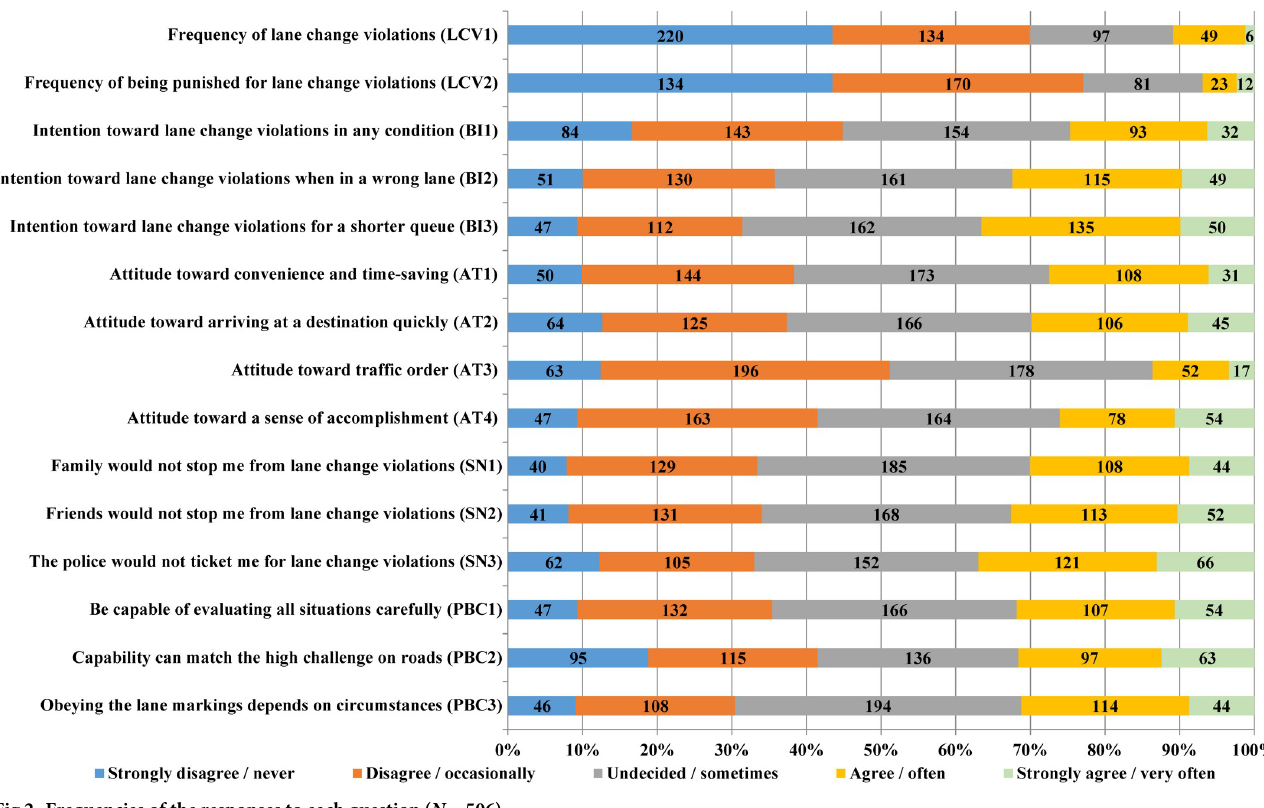
Fig 2. Frequencies of the responses to each question ( N = 506). https://doi.org/10.1371/journal.pone.0216751.g002 The score values of the five constructs were calculated using the average score values of their corresponding items. Means and standard deviations of constructs and items are reported in Table 4 as well as skewness and kurtosis values of all items. Table 4. Descriptive statistics of the constructs and items ( N =